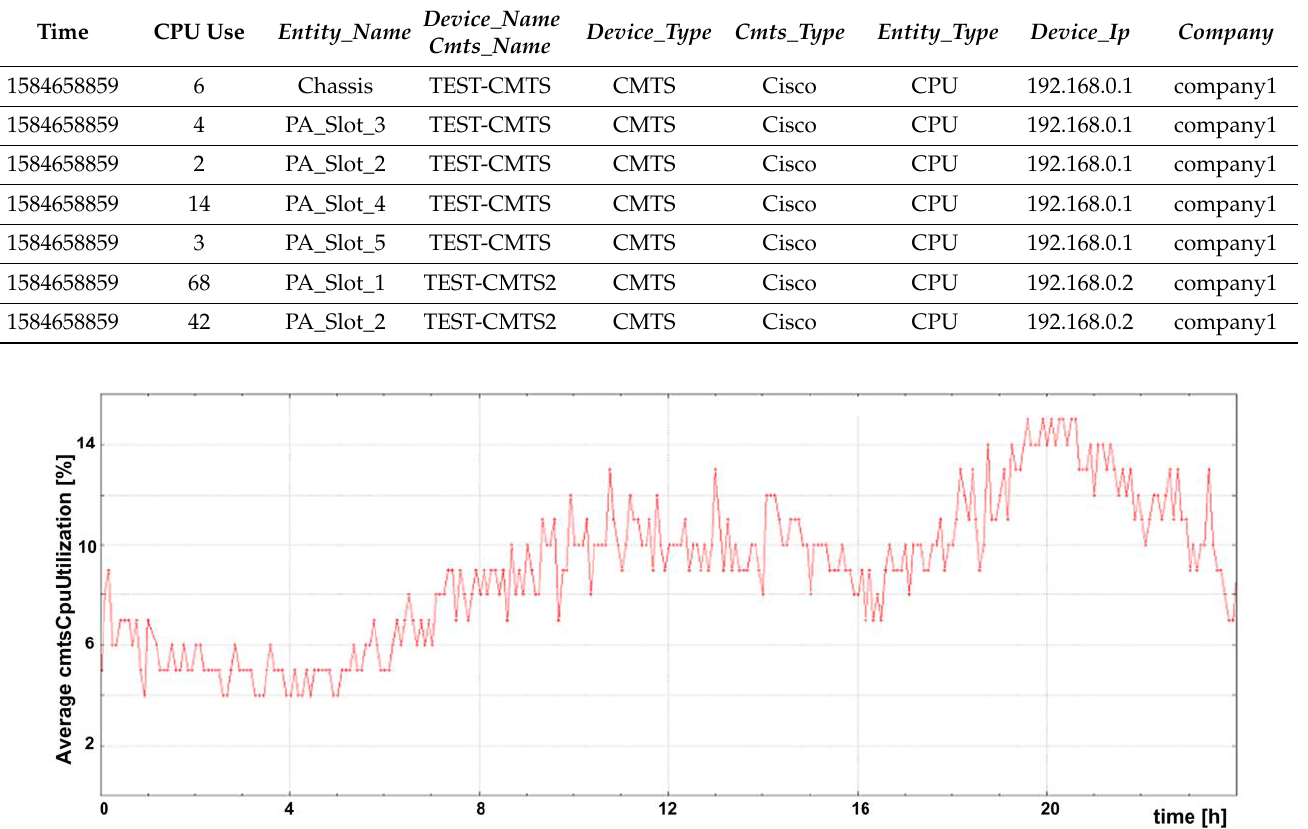
Figure 5. Average CMTS CPU utilization.